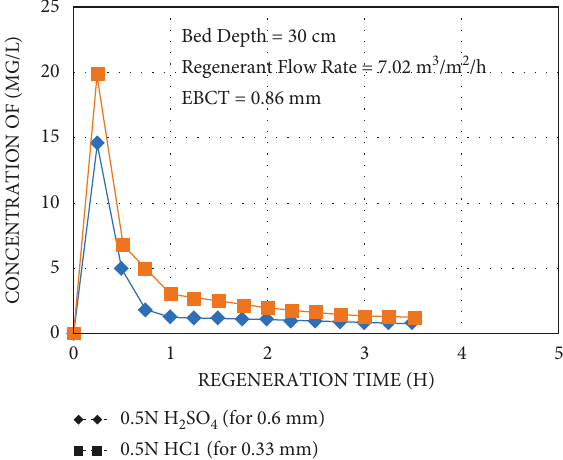
Figure 8: Regeneration time vs. concentration removal. Table 4: Regeneration and recovery efficiency.